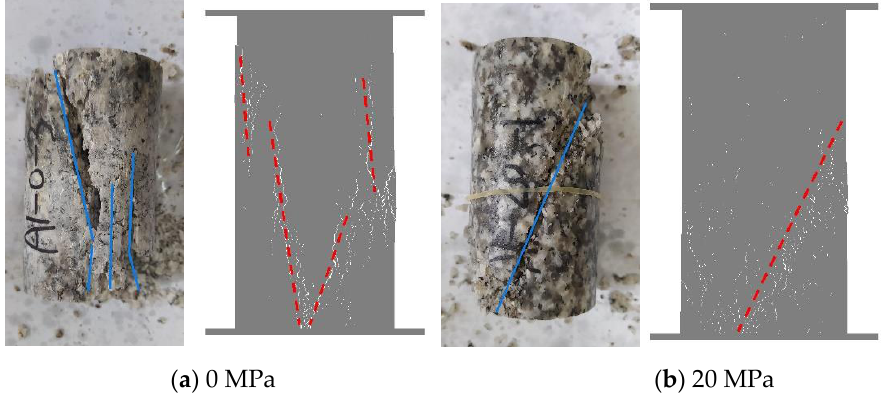
ent confining pressure conditions. confining pressure conditions.